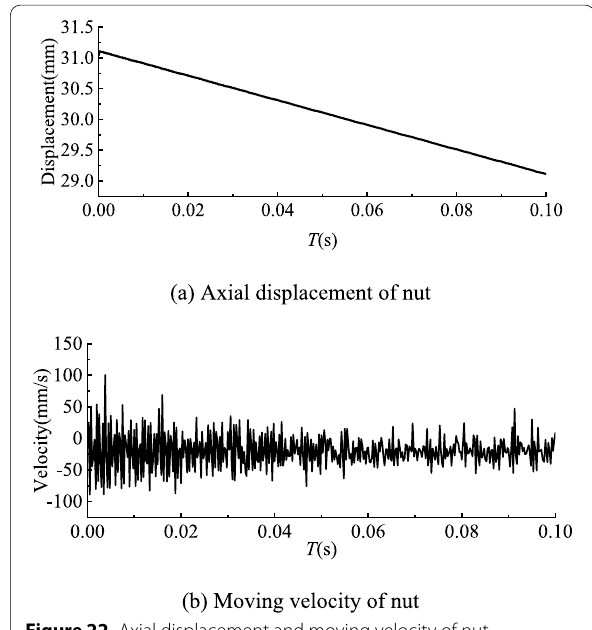
Figure 22 Axial displacement and moving velocity of nut